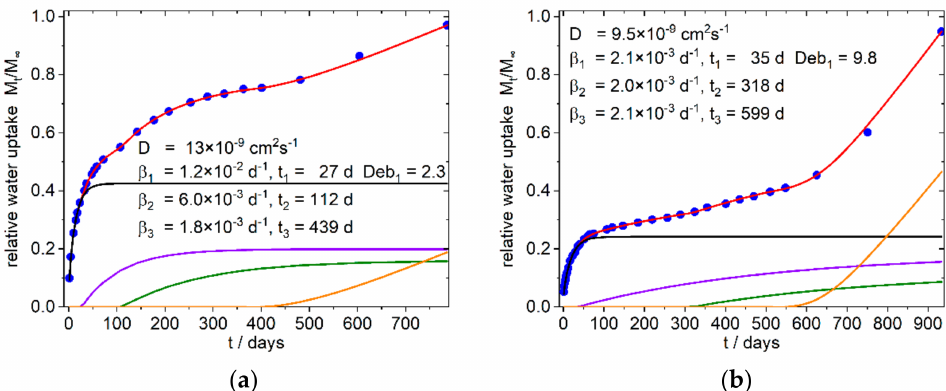
Figure 6. Simulation of water uptake of the reference Composites: ( a ) 9:1-0-0; ( b ) 4:3-0-0; Blue dots: experimental normalized values, red line: simulation, black line: diffusion part of water uptake, purple and olive line: part of water uptake from the relaxation processes 1 and 2, orange line part of water uptake from the exponential growth of water uptake. The nearly identical shaped graph for the 3:4-0-0 composite is shown in the supplementary materials (Figure